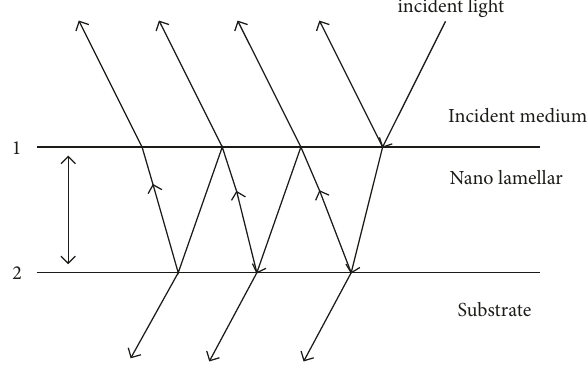
Figure 5: Transmission and reflection of graphene